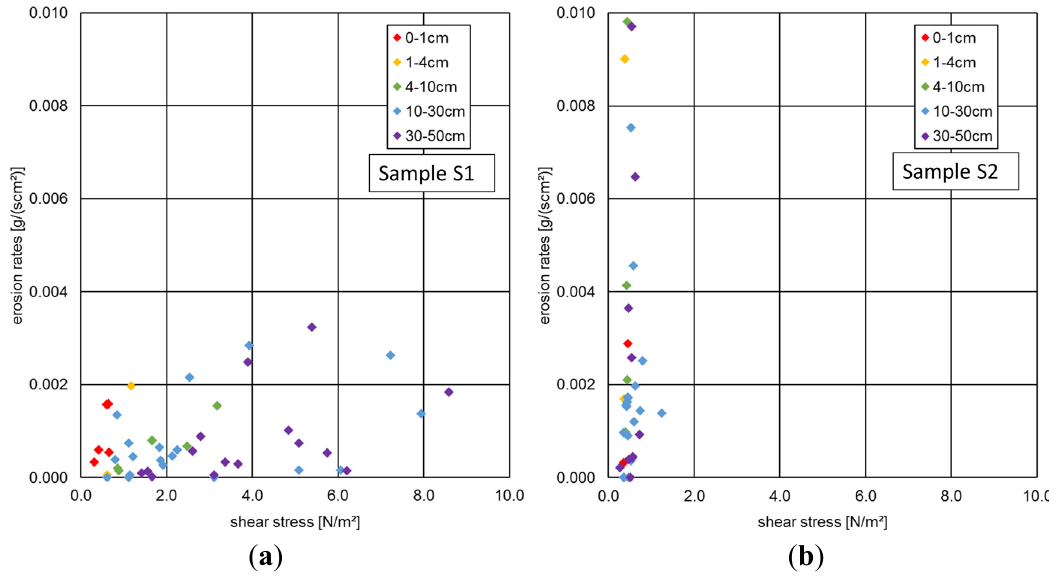
Figure 6. Measured erosion rates in the catchment of River Saale at a stepwise increase of hydraulic forces expressed by shear stresses (( a ): sample S1, ( b ): sample S2). The colors show the different sediment layers over depths.